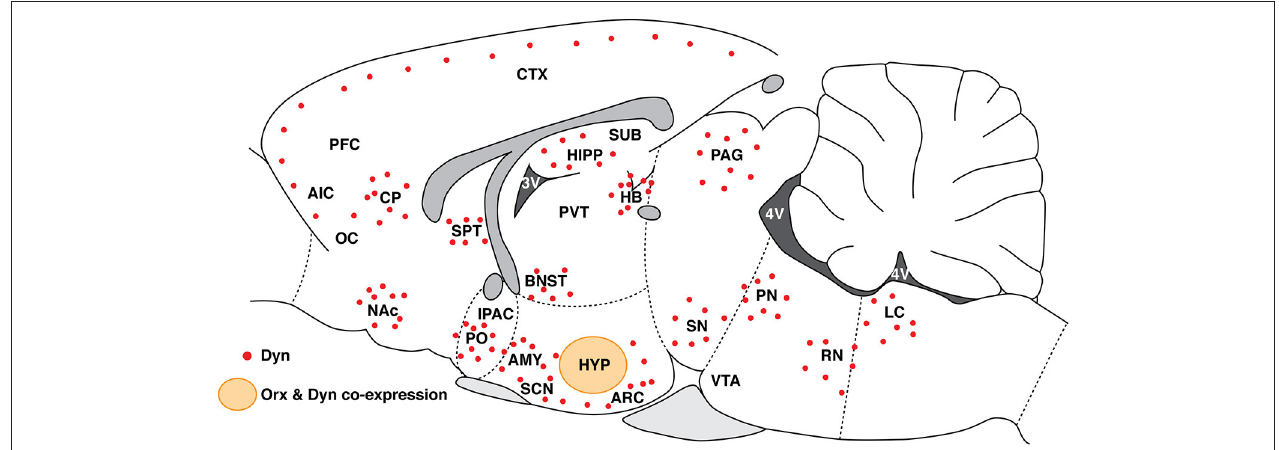
FIGURE 2 | Schematic representation of Dyn distribution (red dots) along the rostro-caudal axis in brain regions that are involved in drug addiction. The orange circle represents the Orx and Dyn overlapping region in the HYP. HYP, hypothalamus; PVT, paraventricular nucleus of the thalamus; ARC, arcuate nucleus of the hypothalamus; LC, locus coeruleus; RN, raphe nucleus; PN, parabrachial nucleus; CTX, cortex; PFC, prefrontal cortex; AIC, agranular insular cortex; OC, orbital cortex; CP, caudate-putamen; SPT, septum; AMY, amygdala; PAG, periaqueductal gray; BNST, bed nucleus of the stria terminalis; NAc, nucleus accumbens; IPAC, interstitial nucleus of the posterior limb of the anterior commissure; PO, preoptic area; HIPP, hippocampus; SUB, subiculum; SN, substantia nigra; VTA, ventral tegmental area; SCN, suprachiasmatic nucleus.